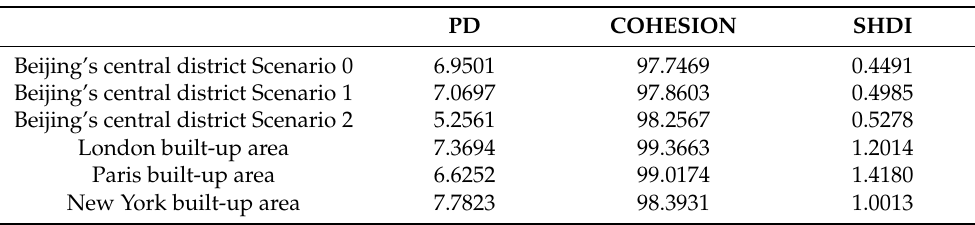
Figure 8. The Distribution of Green Spaces in Three International Metropolises in 2016. Table 6. A Comparison of Green Space Patterns in Beijing’s Central District with Landscape Patterns in Three International Metropolises in 2035.